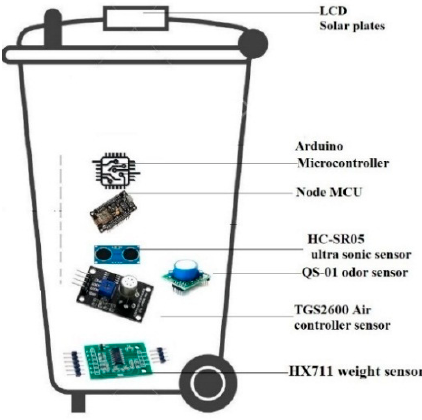
Figure 3. Smart bin used in SGCS.